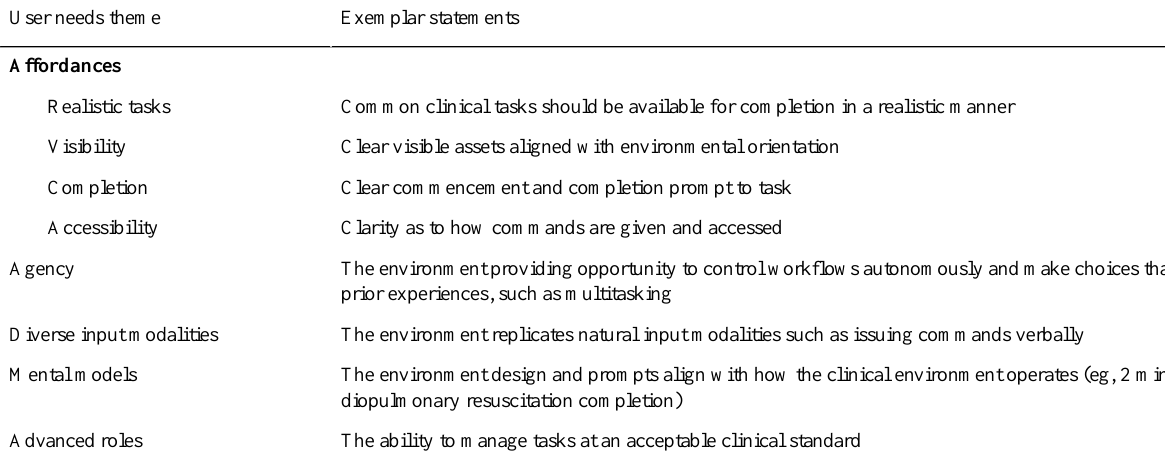
Table 1. User needs groupings and exemplar